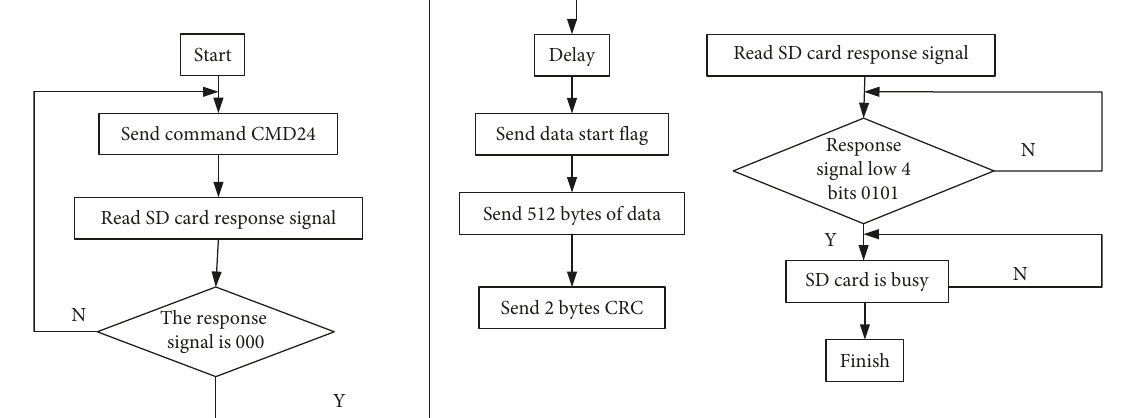
Figure 9: SD card operation process. Table 1: Mean and variance of GPS data.